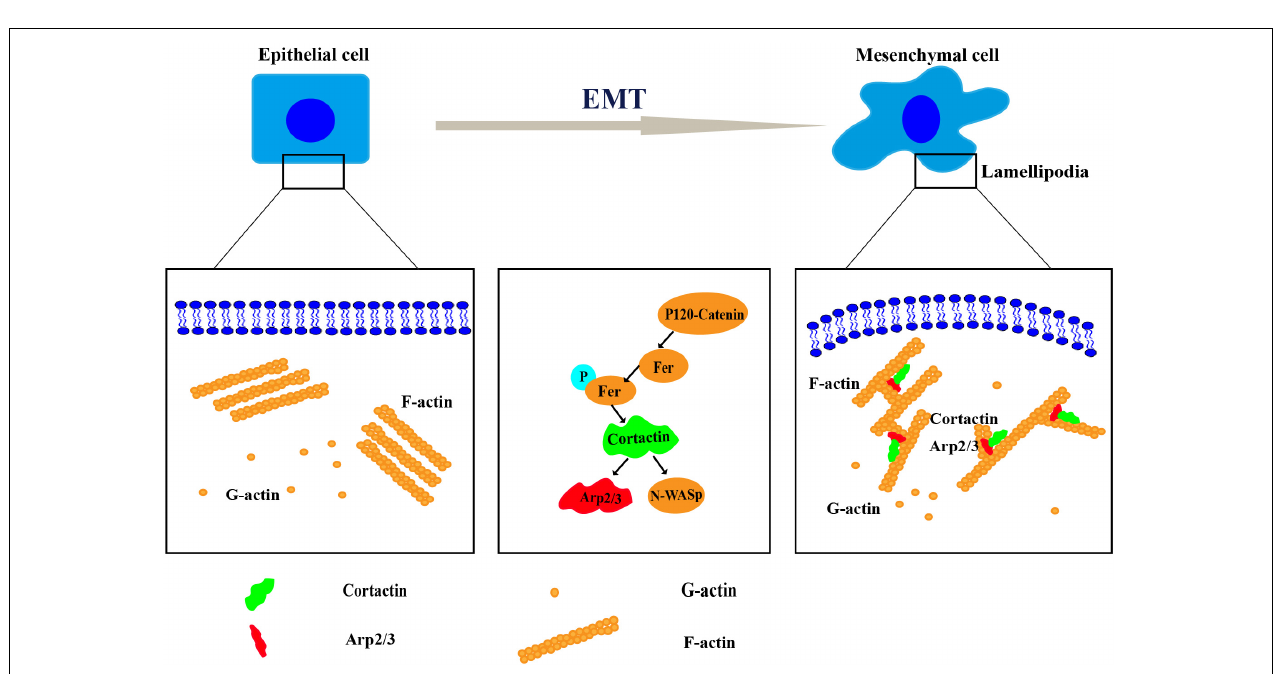
FIGURE 2 | The mechanism of cortactin-induced cytoskeletal remodeling during the epithelial–mesenchymal transition (EMT). Remodeling of the cytoskeleton requires the coordination of several processes, including the protrusion of a lamellipodium at the leading edge, adhesion, contraction of the actin bundle, and retraction of the trailing edge of the cell. Cortactin regulates cytoskeletal remodeling by interacting with Arp2/3, neural Wiskott–Aldrich syndrome protein (N-WASP), and other proteins. Then, it promotes the EMT.